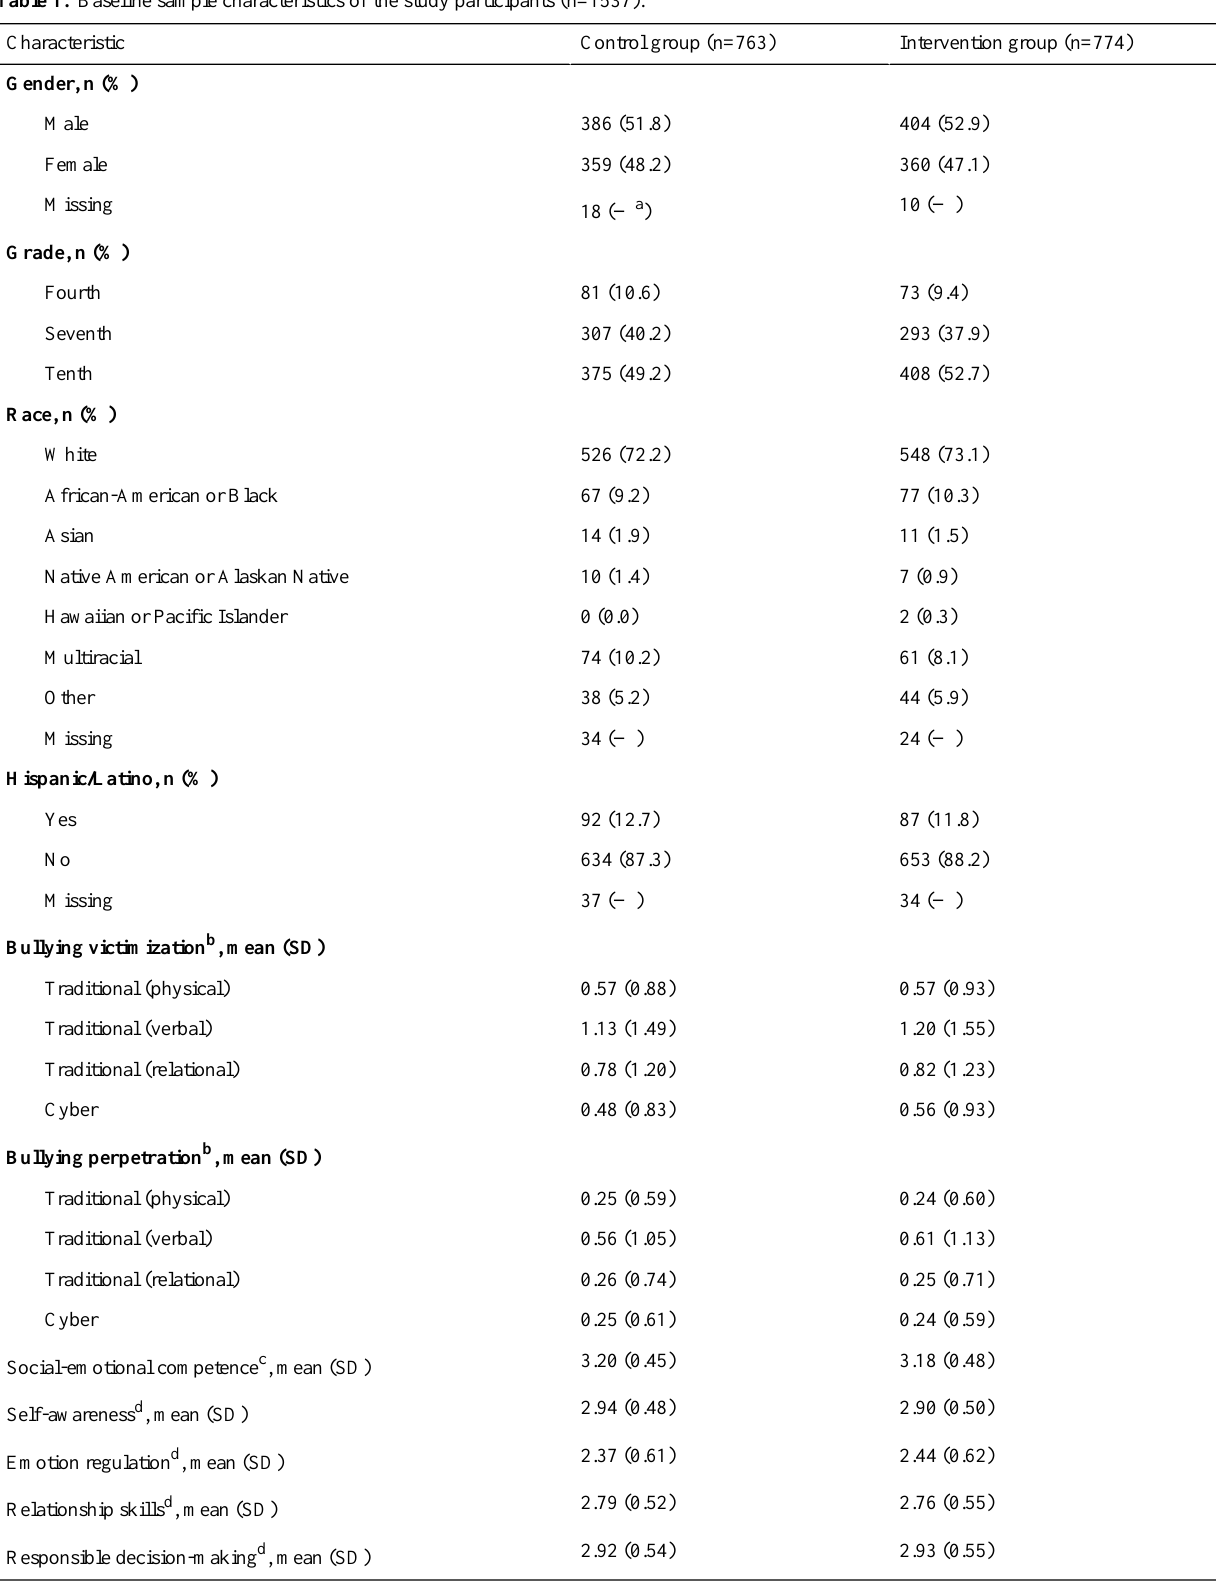
Table 1. Baseline sample characteristics of the study participants